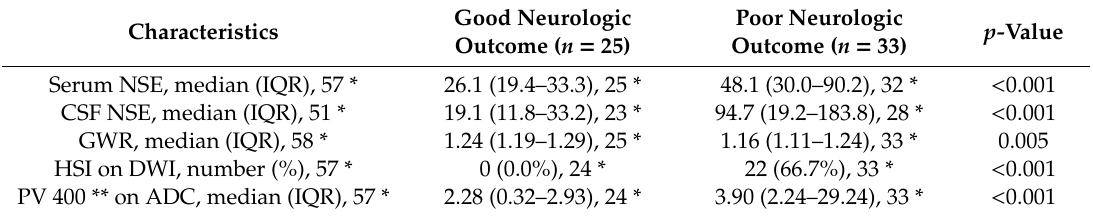
Table 2. NSE levels of serum and cerebrospinal fluid (CSF), grey-to-white matter ratio (GWR), high signal intensity (HSI) in DWI, and percentage of voxels (PV) 400 ** of ADC.